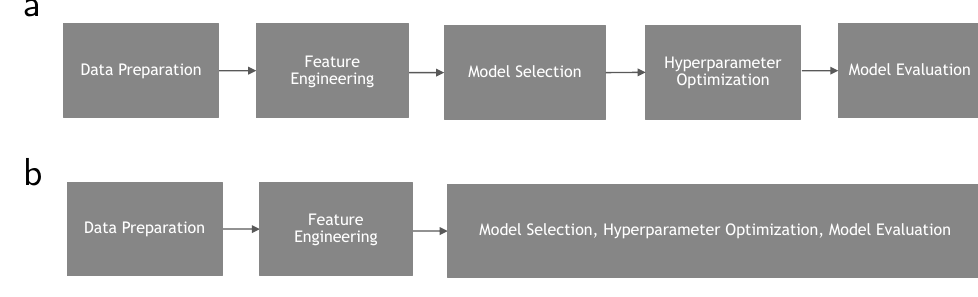
Figure 3. ( a ) the different stages of the AutoML process for selecting and tuning classical ML models; ( b ) AutoML stages for generating and tuning models using neural architecture